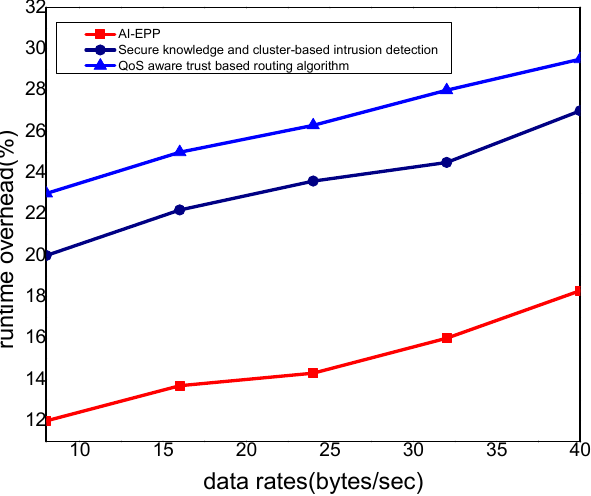
Figure 12. Runtime overhead comparison using simulations with varying data rates.